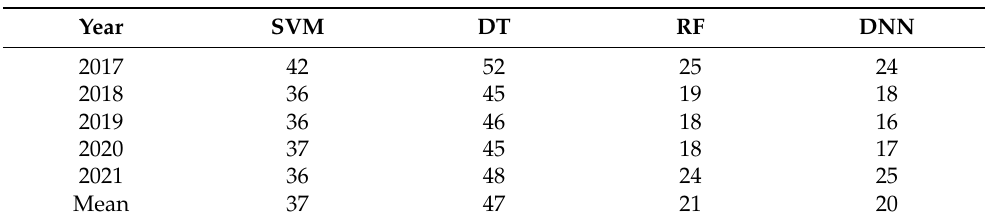
Table 3. The percentage of samples removed by the ensemble learning of the four algorithms each